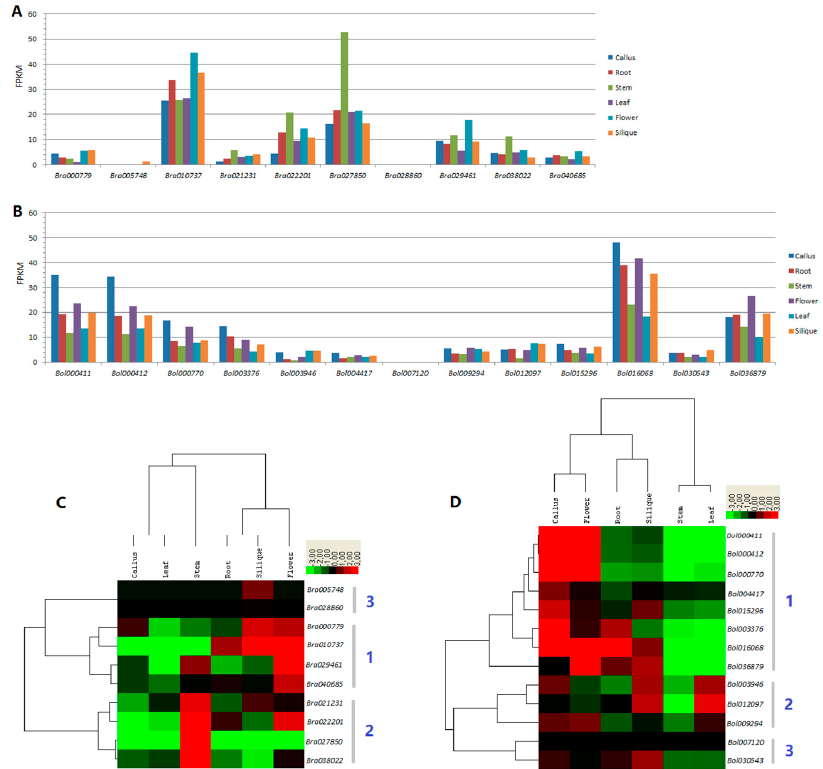
Figure 6. Expression analysis of HECT genes in B. rapa ( A , C ) and B. oleracea ( B , D ). The expression profile data of 10 B. rapa and 13 B. oleracea HECT genes across six di ff erent tissues (callus, root, stem, flower, leaf, and silique) were obtained from the Gene Expression Omnibus (GEO) database of NCBI (GSE43245 and GSE42891). Expression levels (numbers of fragments per kilobase of transcript per million mapped reads, FPKM) of each HECT gene in six di ff erent tissues were illustrated by histograms in B. rapa ( A ) and B. oleracea ( B ). Clustered heatmaps were generated for the 10 B. rapa ( C ) and 13 B. oleracea ( D ) HECT genes based on same sets of FPKM values. Color scale bars representing the relative signal ratios are shown on right top side of each heatmap. The tissue types are indicated on the right side of each histogram figure ( A , B ) and top of each heatmap ( C , D ). The individual gene names are indicated on the bottom of each histogram figure ( A , B ) and right side of each heatmap